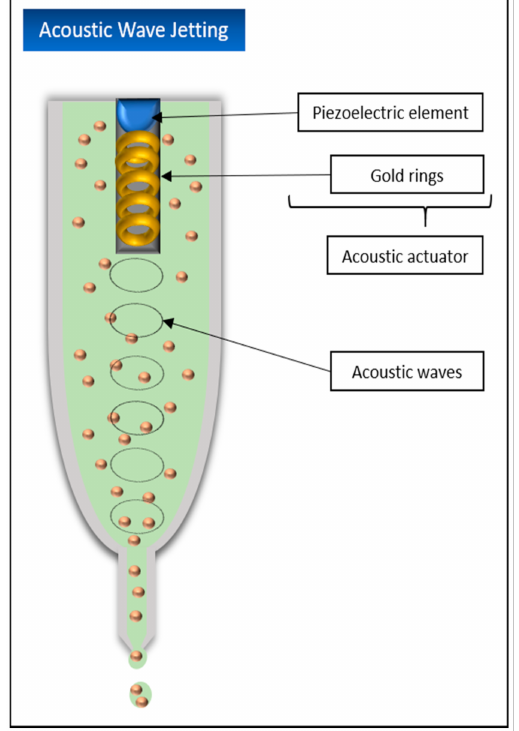
Figure 8. Schematic representation of the acoustic wave jetting. The generation of sound waves is used to spray the print material out of the